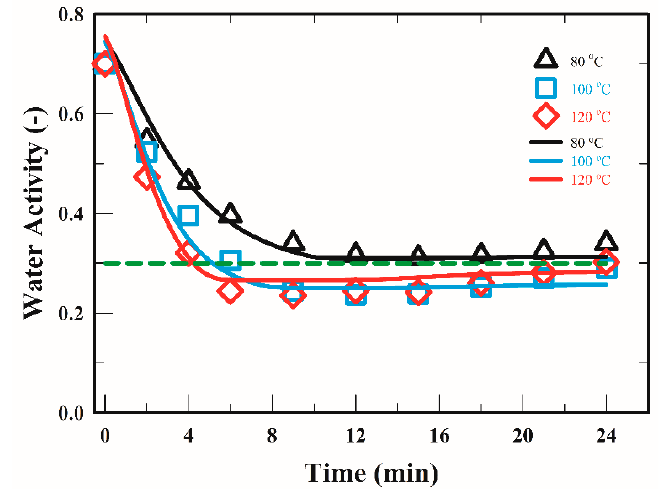
Figure 4. Profiles of the water activity of wheat germ during drying in the FBD at different set temperatures. The symbols represent the experimental data; the solid lines represent the simulated values; the dashed line represents the target water activity of 0.3.